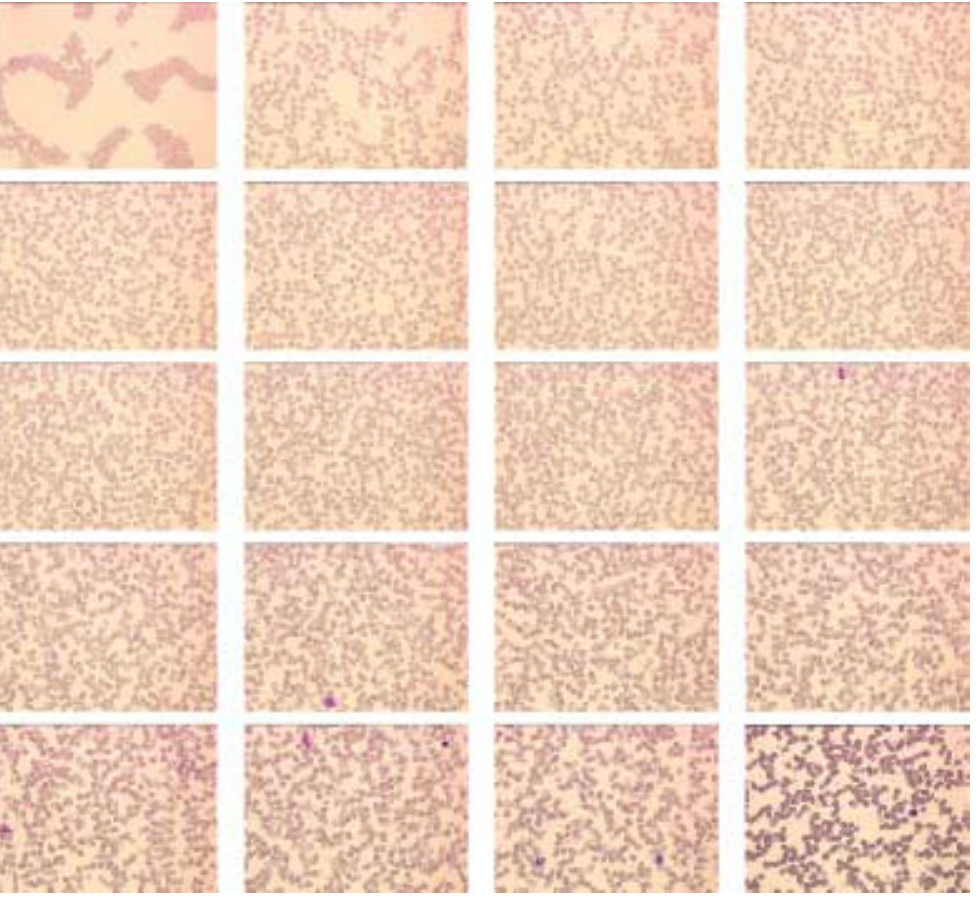
Fig. 2. Series of 20 blood images obtained from the same film and covering the whole smear ( Smear 0 , × 25). This figure can be viewed on http://